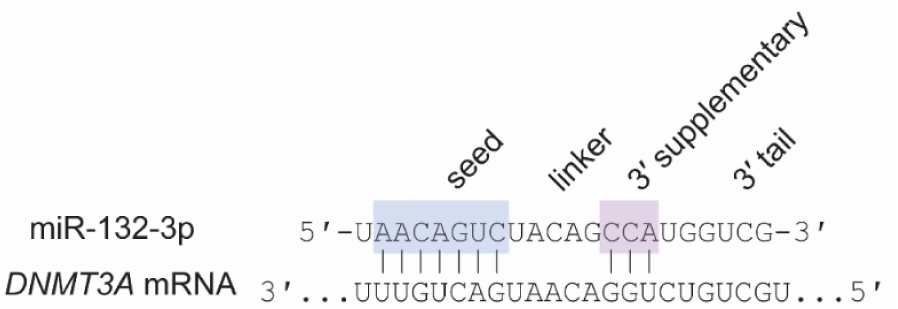
Figure 2. Anatomy of a miRNA. The miR-132-3p canonical sequence targets several sites within the DNMT3A-3 (cid:48) UTR, including the one shown (interaction predicted by miRbase). Targeting is mostly dictated by the seed sequence (shaded in blue) within the miRNA: nucleotides 2-7 or 2-8 (5 (cid:48) to 3 (cid:48) ). Additional targeting can occur within the 3 (cid:48) supplementary region (shaded in pink), which is separated from the seed sequence by a noncomplementary linker sequence. The linker sequence varies in length, depending on the target and the position of the 3 (cid:48) supplementary region. The final nucleotides near the 3 (cid:48) end of the miRNA form the miRNA’s 3 (cid:48) tail. The 3 (cid:48) tail rarely contributes to mRNA targeting but undergoes frequent editing by exonucleases, which trim the miRNA, and nucleotidyl transferases, which add nucleotides to the tail of the